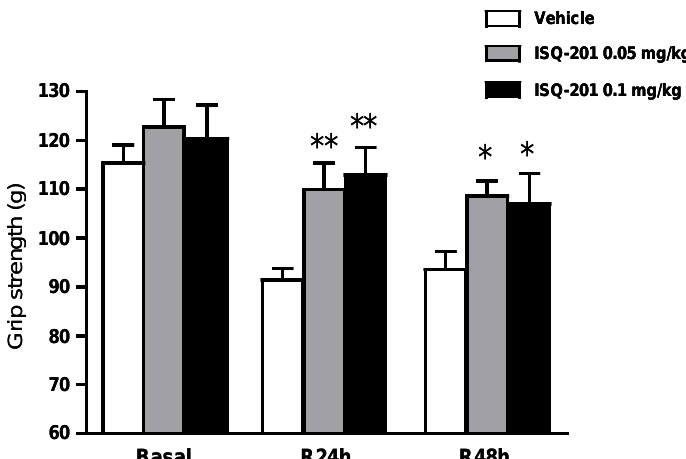
Figure 9. Improvement of the functional outcome of ISQ-201 treatment after transient focal ischemia. The functional motor deficit was evaluated by a grip strength test. Vehicle or ISQ-201 (0.05 and 0.1 mg / kg) was administered at the onset of the reperfusion after tMCAO, and the grip strength values were recorded at 24 and 48 h of reperfusion (R24h and R48h, respectively). The bar graph shows the values corresponding to presurgery animals (basal) and the improved grip strength values in ISQ-201-treated animals at R24h and R48h. Values represent the mean of 9 independent animals, and SE is indicated by error bars, * p < 0.05 and ** p < 0.01, compared to the vehicle using Bonferroni’s post-test after two-way ANOVA.